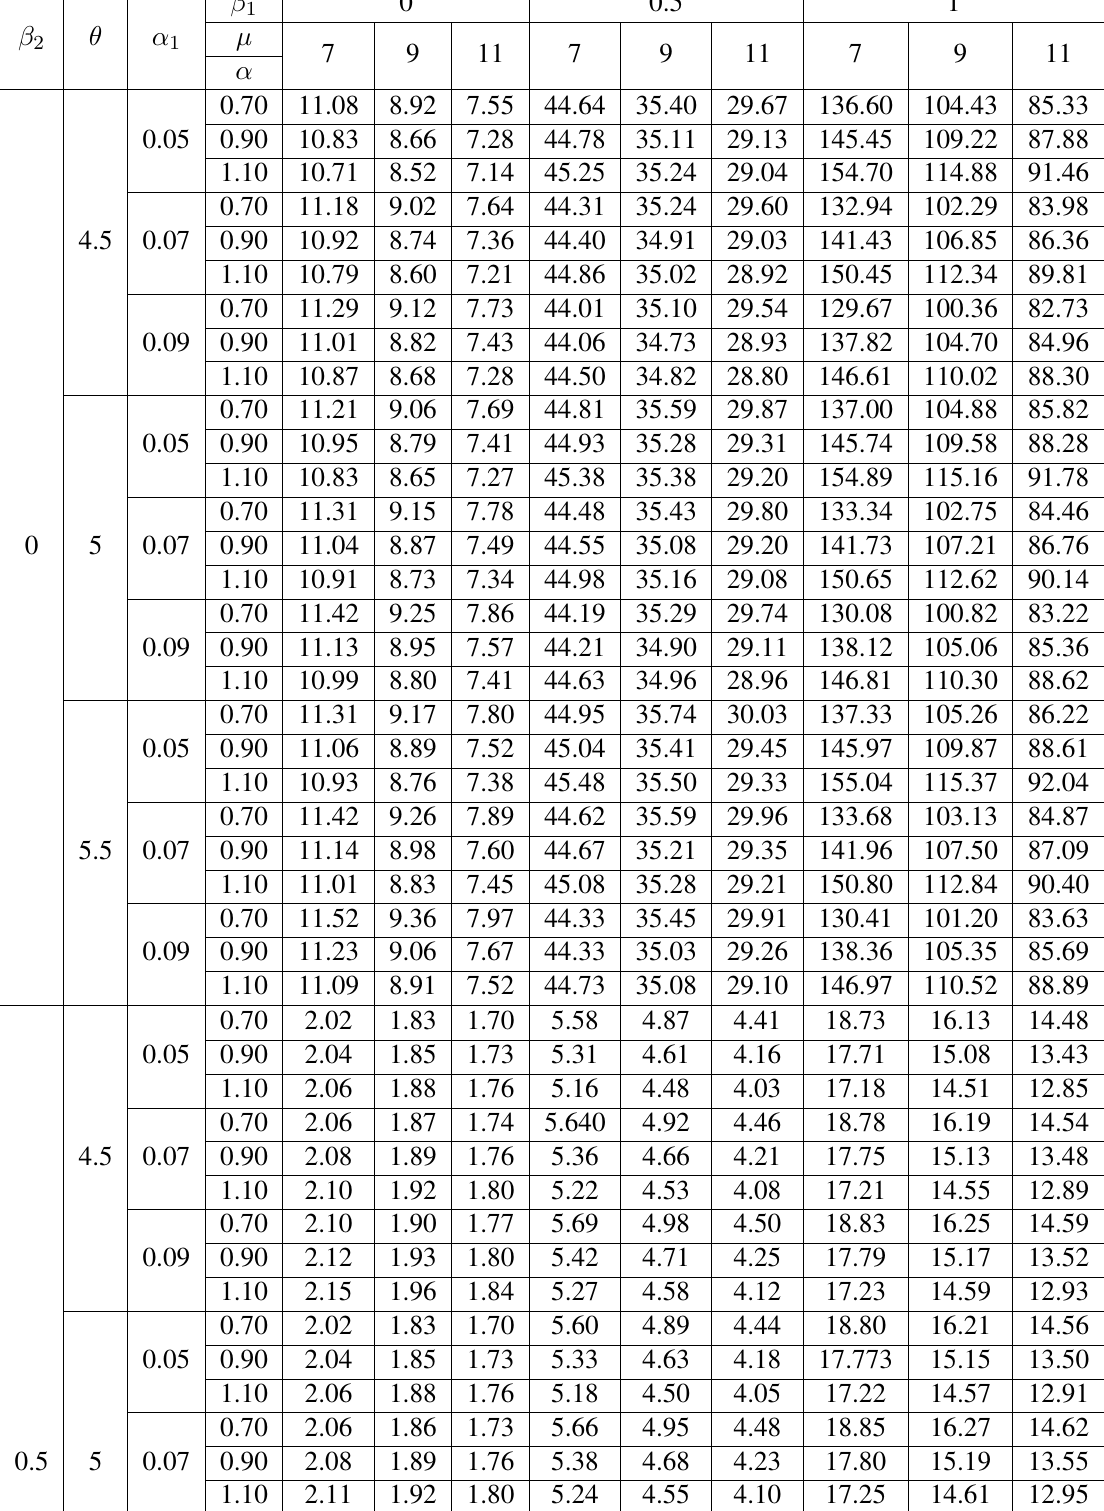
Table 3: The variation of TCV under the parameter variation β